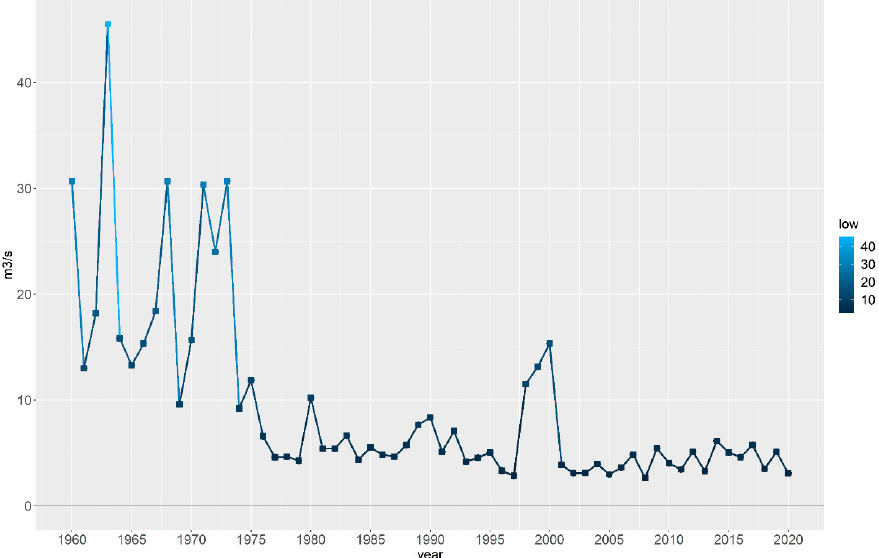
Figure 10. Hydrograph of the low pulse duration index.